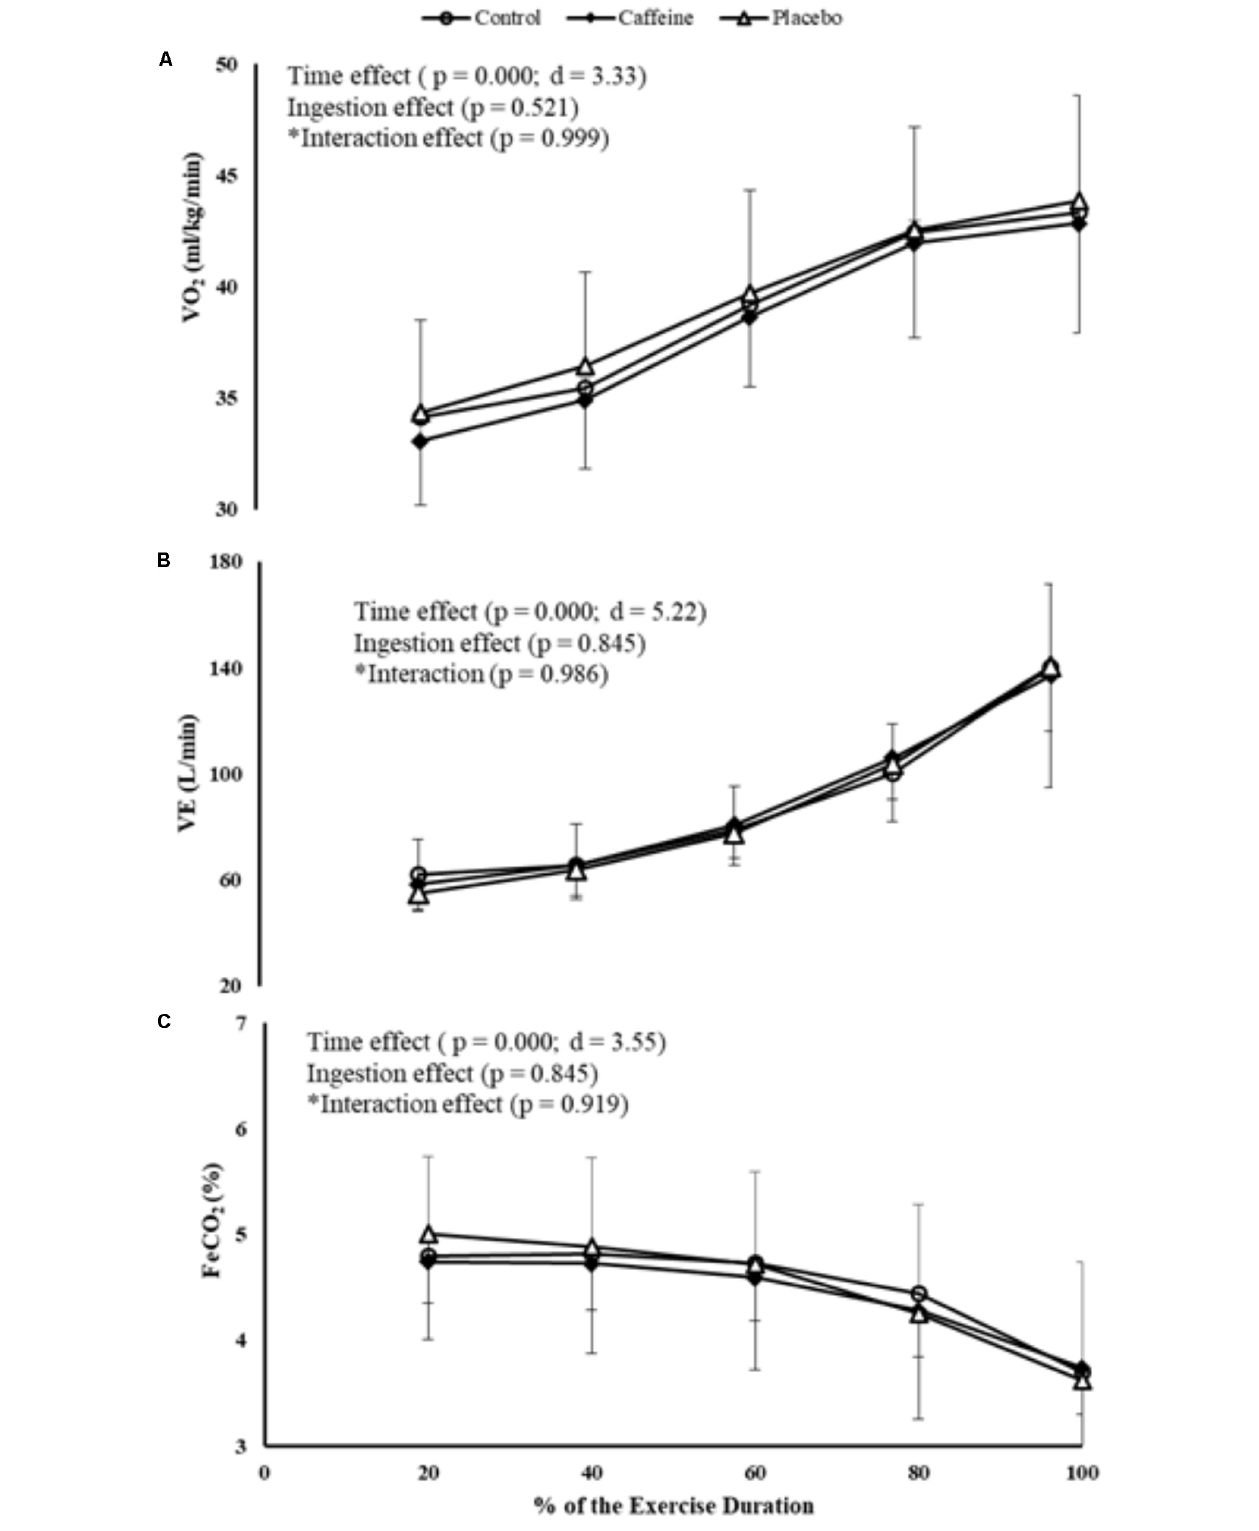
FIGURE 4 | VO 2 (A) , VE (B), and FeCO 2 (C) responses during MIT in control, caffeine and placebo (perceived as caffeine). Main effects of time and ingestion and time by ingestion interaction effects were reported in the figure. Values are mean ( ± SD).